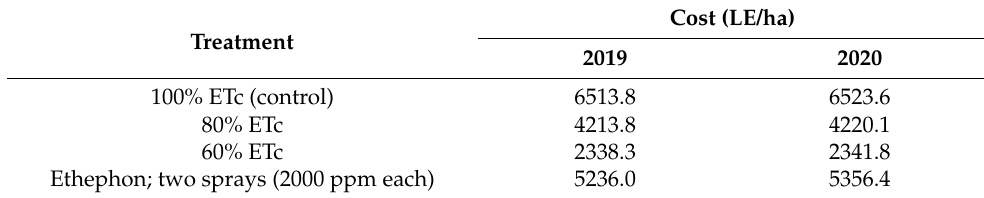
Table 8. Total cost of deficit irrigation treatments and foliar sprays of Ethephon on “African Rose” plum trees during the 2019 and 2020